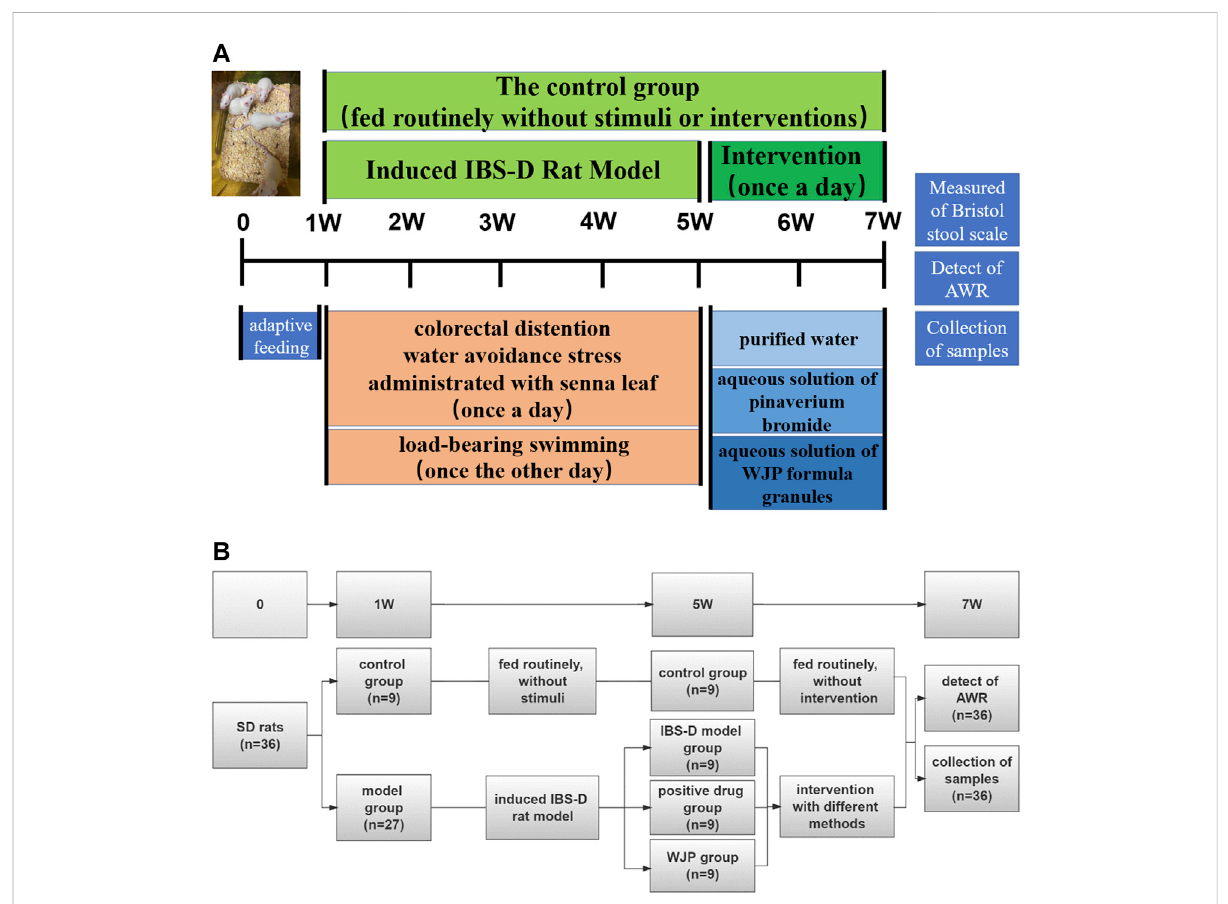
FIGURE 2 Detailed procedures for the experiments and their general conditions. (A) Protocol diagram of the time course involved in the experimental procedures of the IBS-D rat model induced and the intervention. (B) Speci fi c numbers of animals in each group of the experiment.